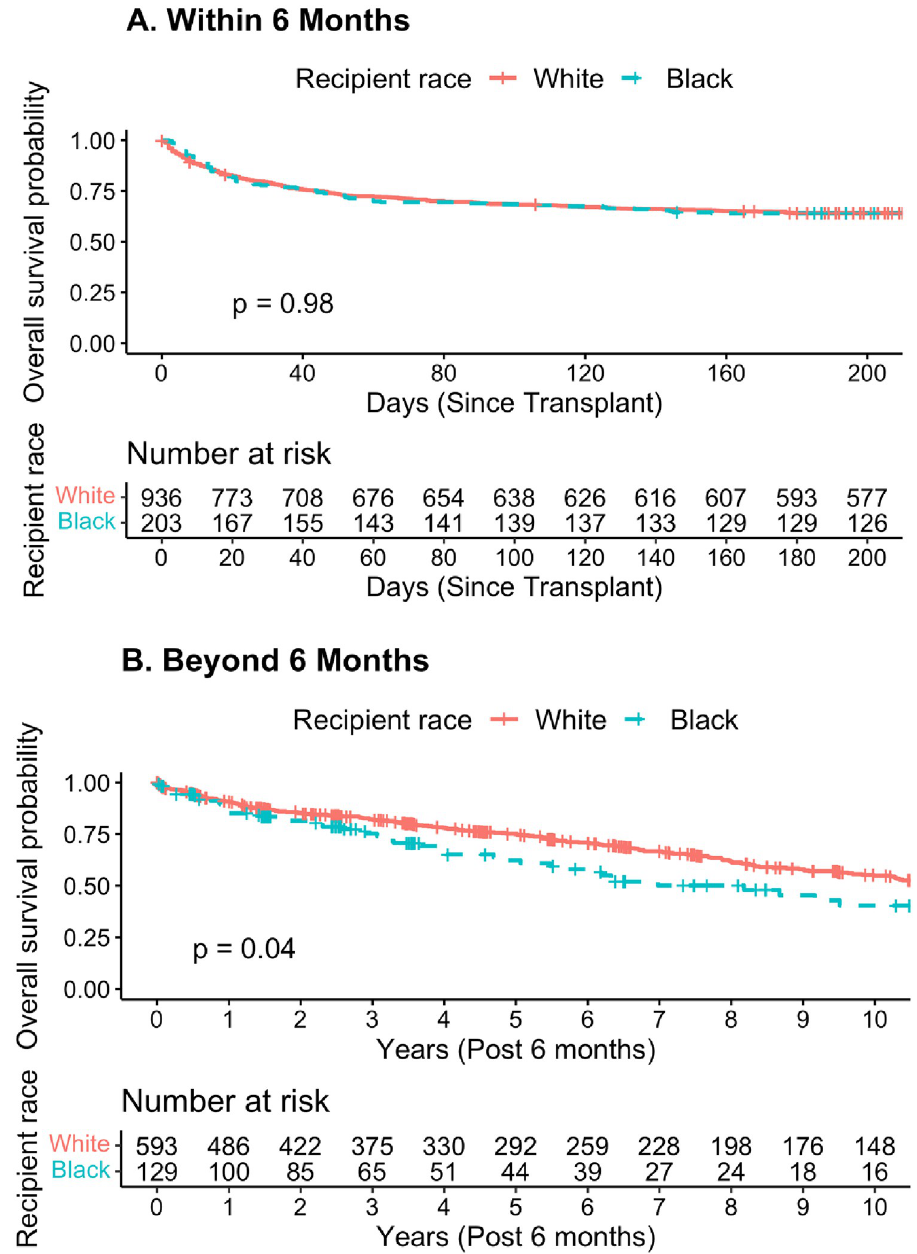
Fig 1. Kaplan Meier survival curves for post-transplant stroke survivors by transplant era, Scientific Registry of Transplant Recipients (SRTR), January 1, 1987 To December 31, 2018. (a) 1987–1999 (b) 2000–2009 (c) 2010–2018.